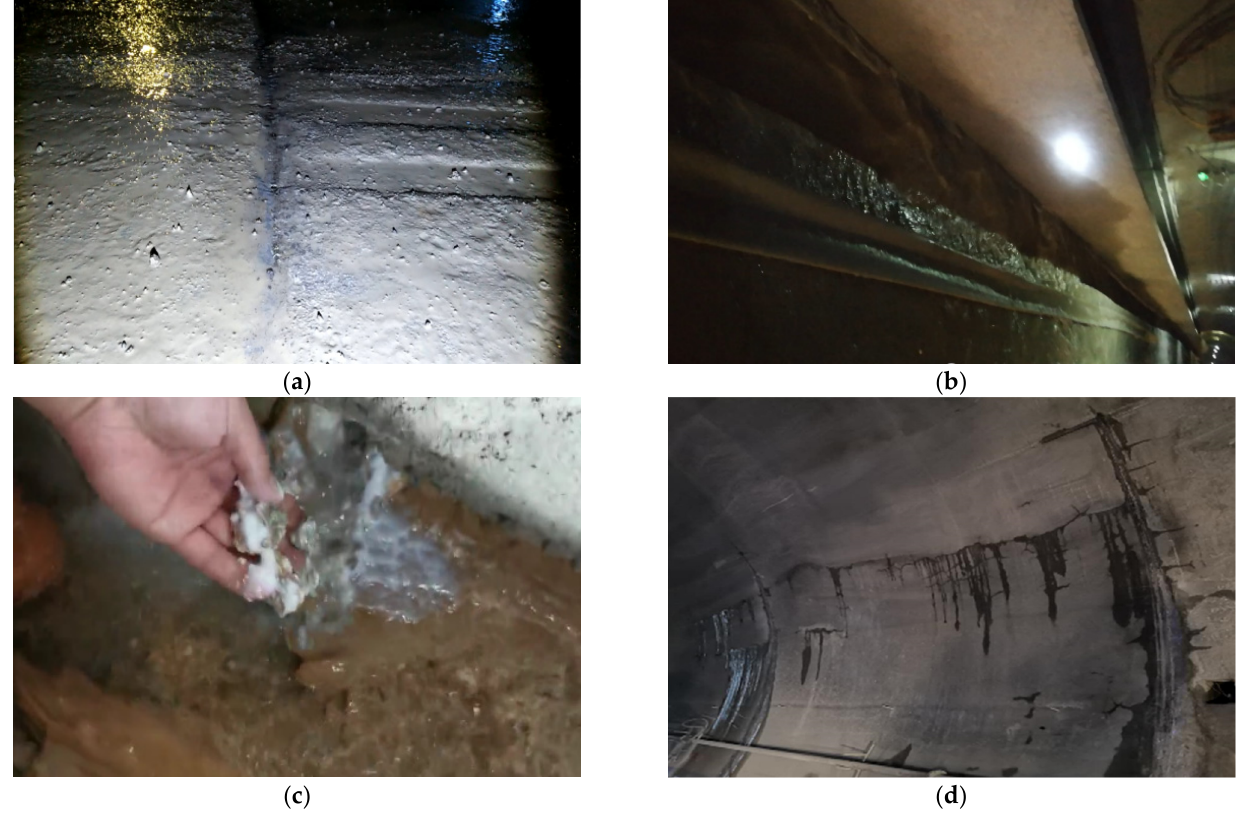
Figure 8. ( a ) Water seepage occurs in the inverted arch construction joint; ( b ) inadequate drain capacity; ( c ) calcium carbonate crystals appear in the circumferential drain pipe; ( d ) cracks appear in the secondary lining structure in part of the water-gushing